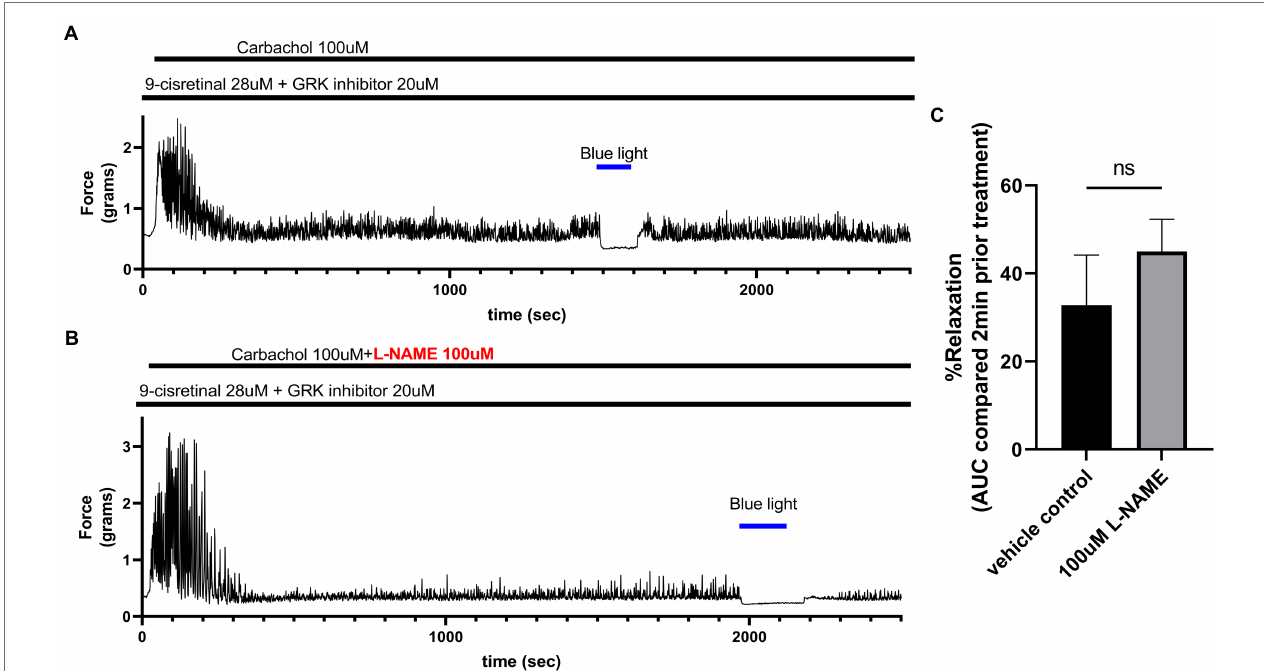
FIGURE 6 | (A) Representative force tracing of colonic rings pretreated with 9- cis retinal 28 μ M + GRK2 inhibitor 20 μ M and constricted with 100 μ M carbachol. Pretreatments depicted by the black bars. Blue bar depicts a 2 min 435 nm blue light treatment. (B) Representative force tracing of colonic rings pretreated with 9- cis